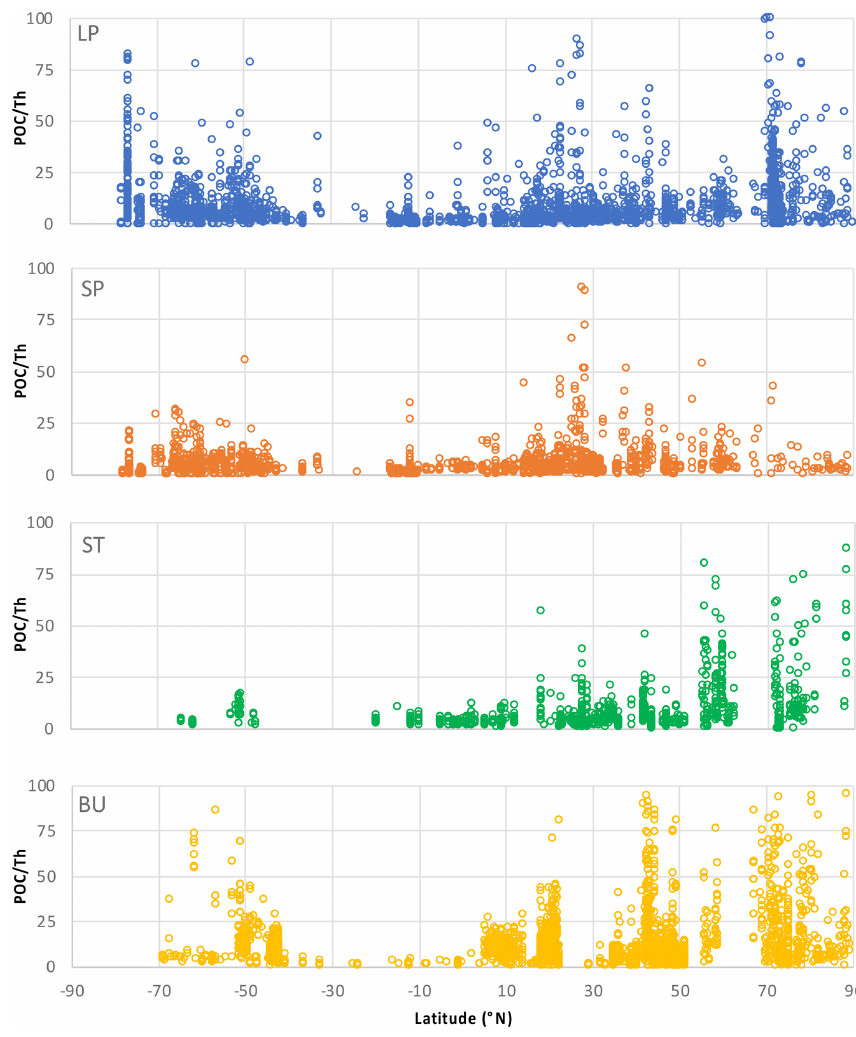
Figure 5. Latitudinal variability of the POC / Th ratios ( < 100µmoldpm − 1 ) grouped by large particles (LPs), small particles (SPs), sediment trap (ST) particles, and bulk (BU)